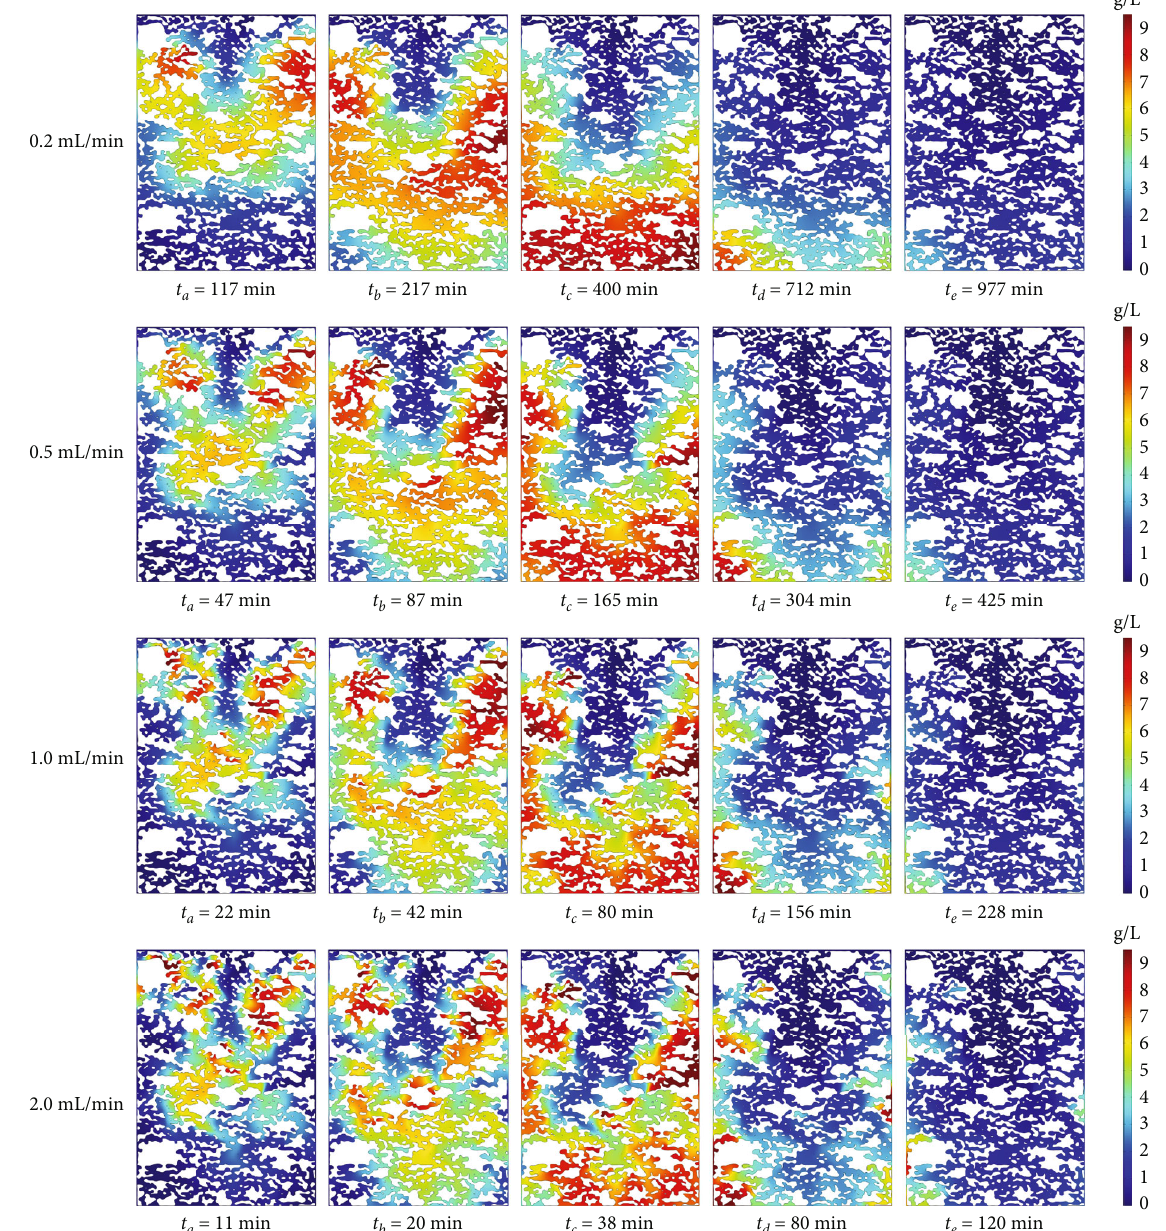
Figure 11: RE 3+ ion migration process under di ff erent injection